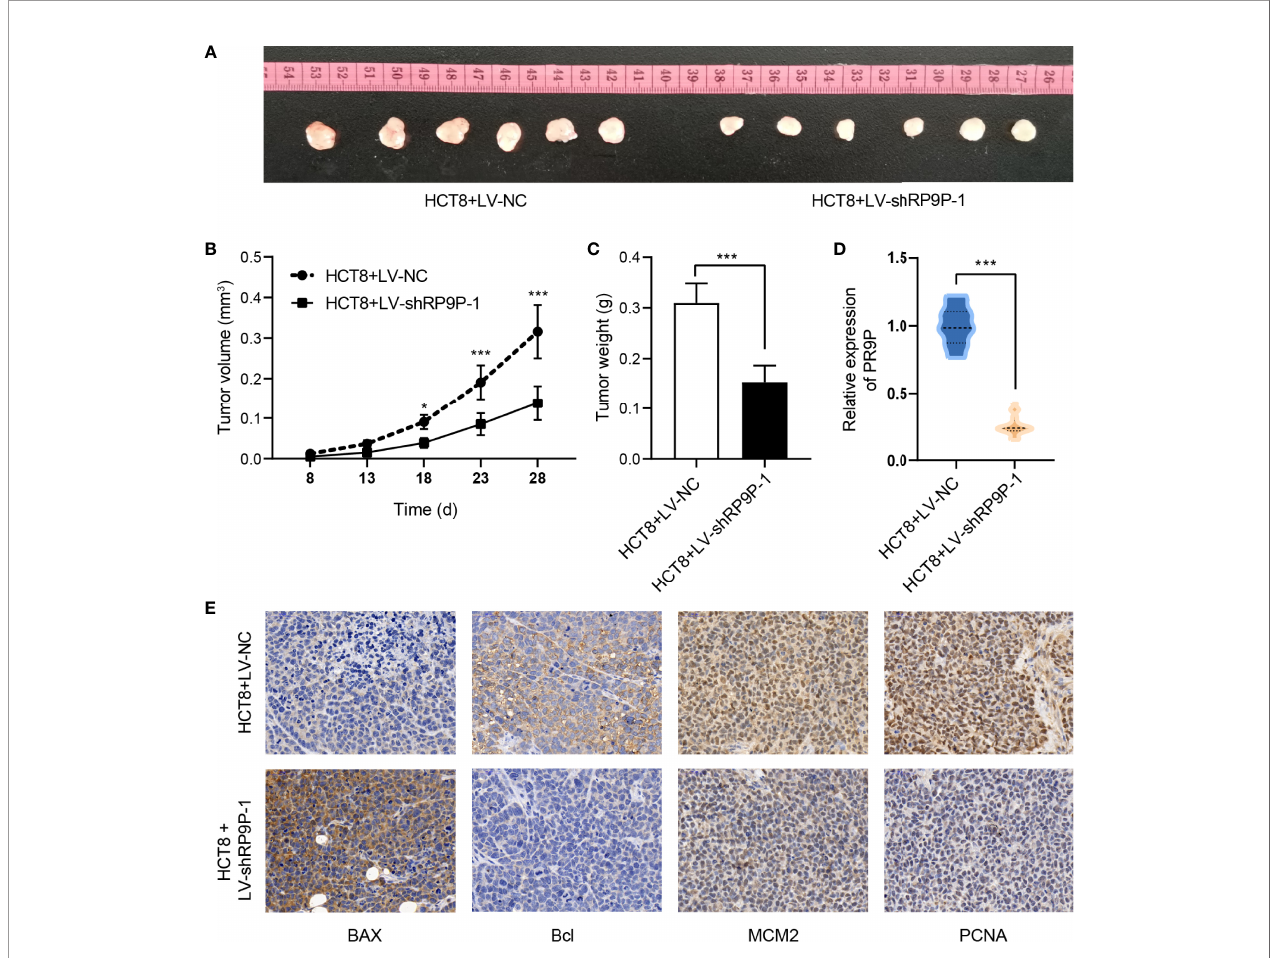
FIGURE 3 | RP9P knockdown suppresses colorectal cancer cell proliferation in a xenograft model. (A) Representative images of transplanted tumors in nude mice. (B, C) Tumor volume (B) and tumor weight (C) . (D) RP9P level in transplanted tumors. (E) Levels of proliferation- and apoptosis-related genes were examined by immunohistochemistry (* p < 0.05, *** p